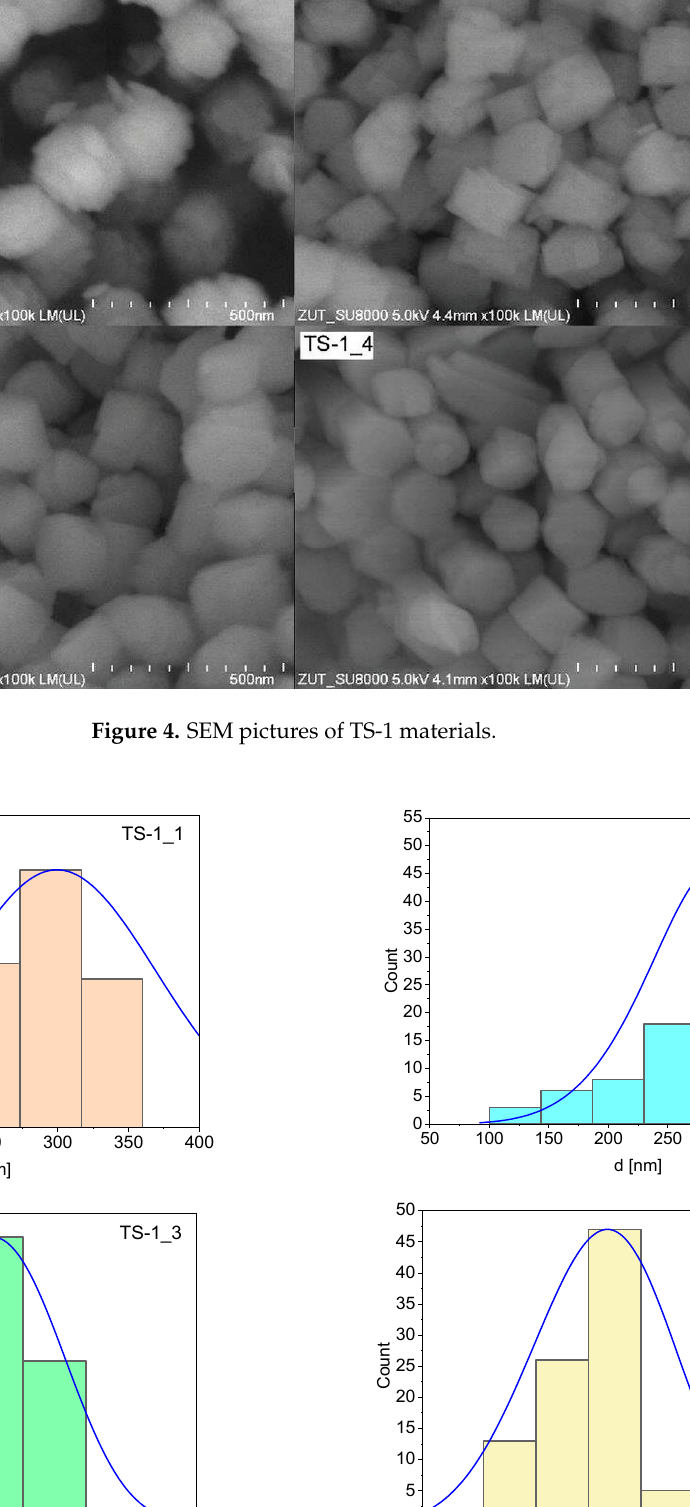
Figure 4. SEM pictures of TS-1 materials.